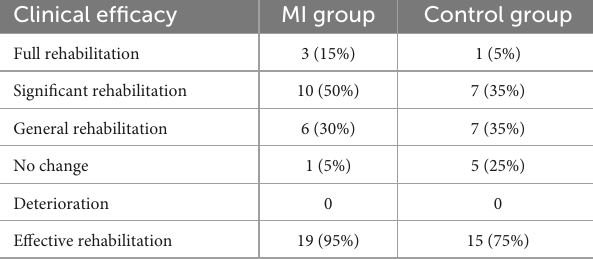
TABLE 5 Comparison of the clinical efficacy between the MI and control group.